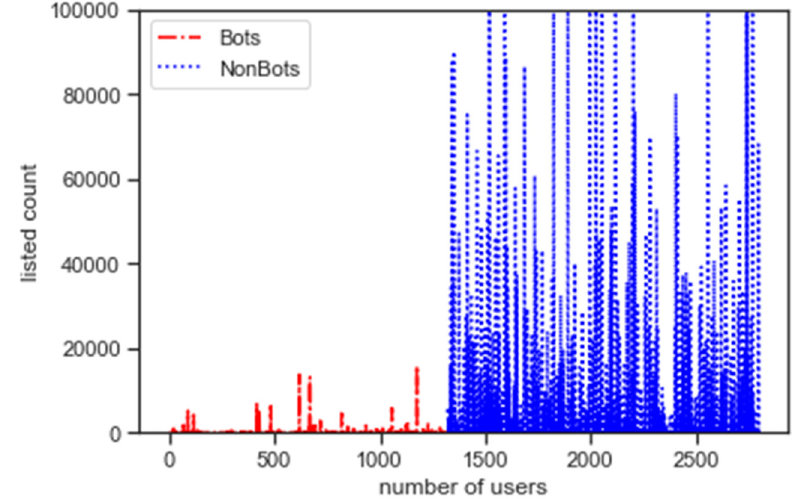
Figure 12. Numbers of Users with Variation of Listed Count.